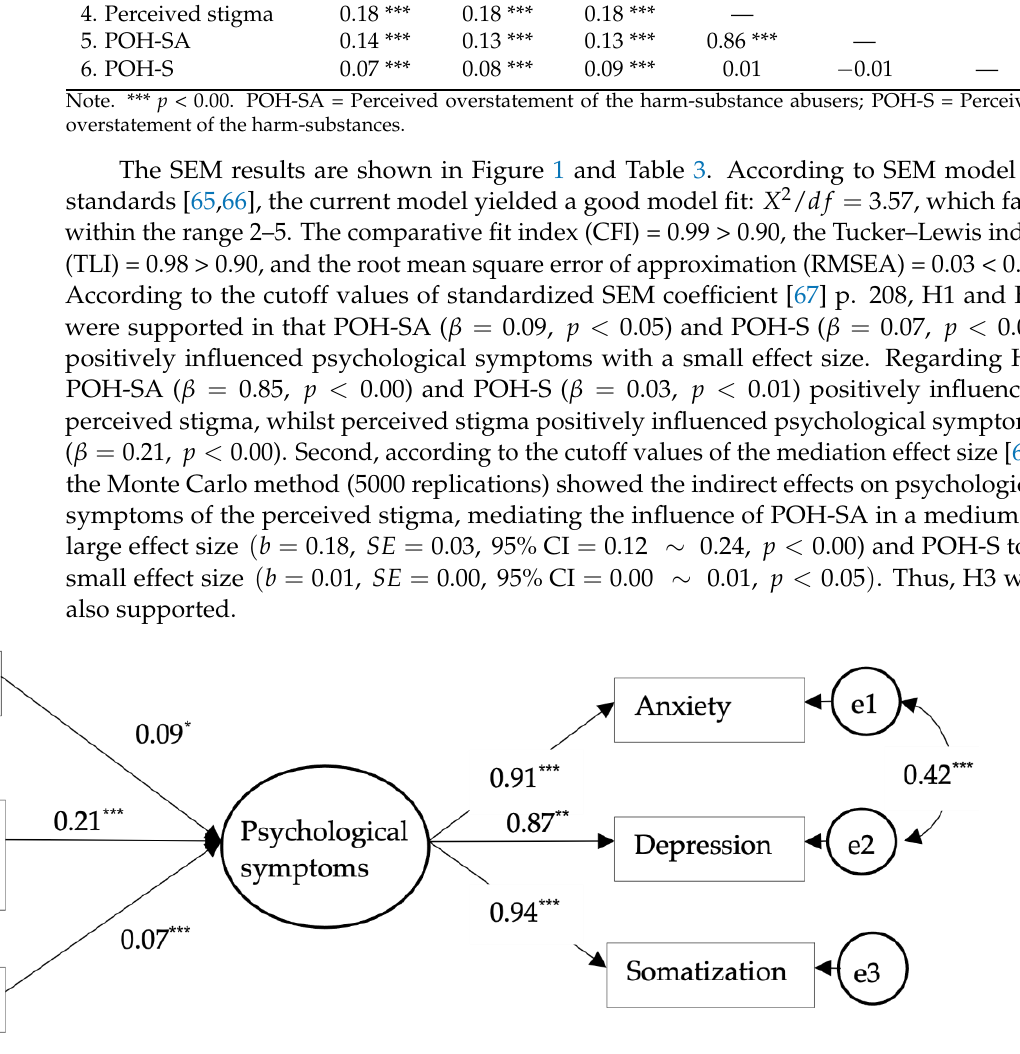
Figure 1. The standardized SEM results. Note. *** p < 0.00, ** p < 0.01, * p < 0.05. POH-SA = Perceived overstatement of the harm-substance abusers; POH-S = Perceived overstatement of the harm-substances.